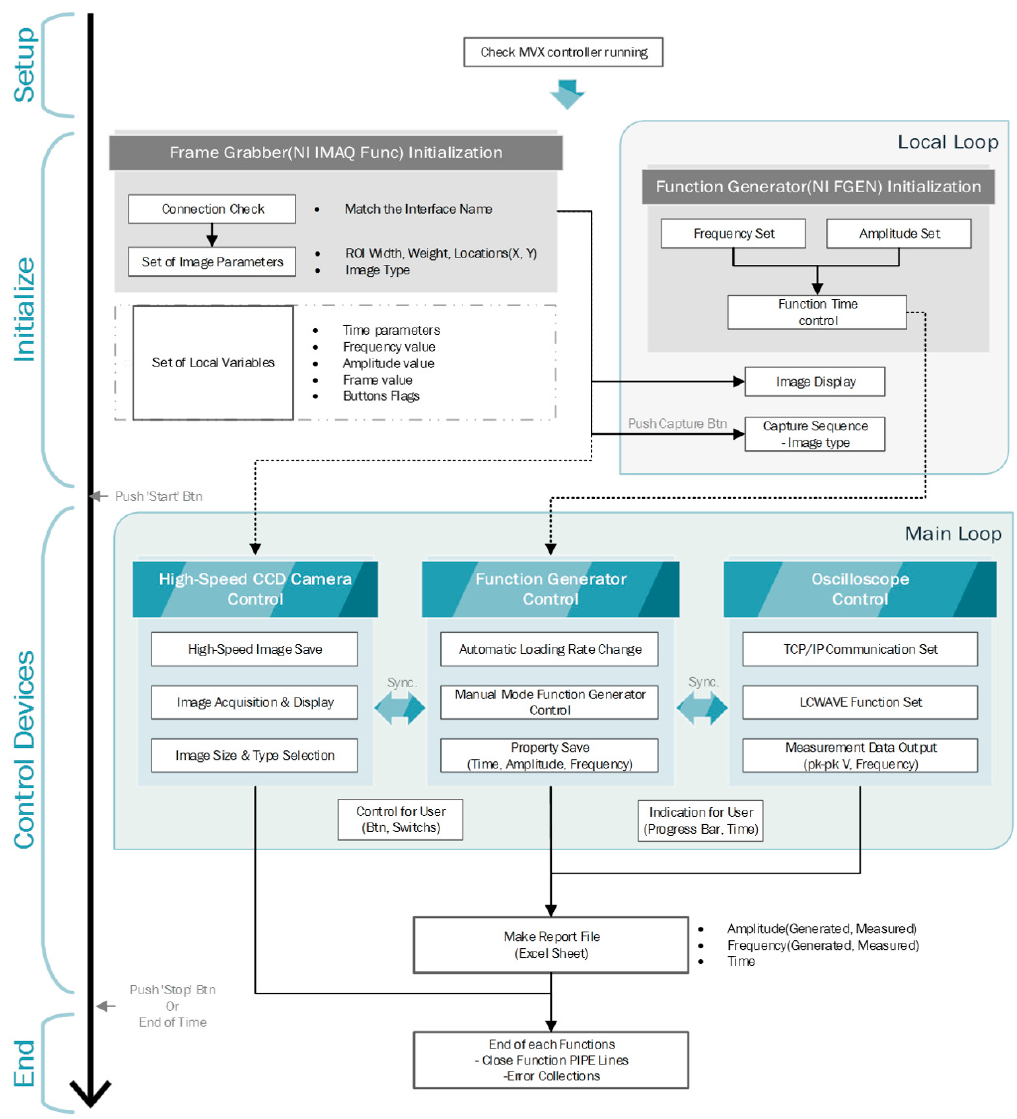
Figure 2. Program structure of the automatic system for DFS using LabVIEW: This structure consists of four sections: the Setup, Initialize, Control Devices, and End sections. Each section describes the role of the devices in the measurement and observation modules, as shown in Figure 1.